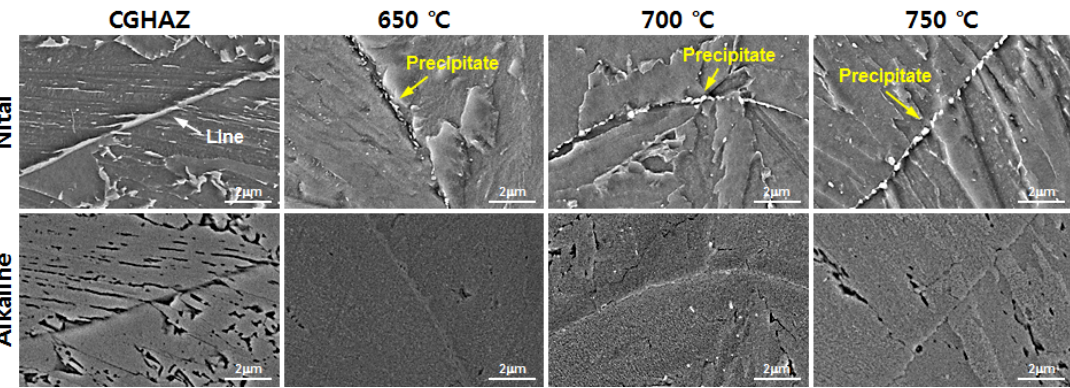
Figure 5. SEM microstructure with etchants (nital, alkaline sodium picrate) at various PWHT temperatures.